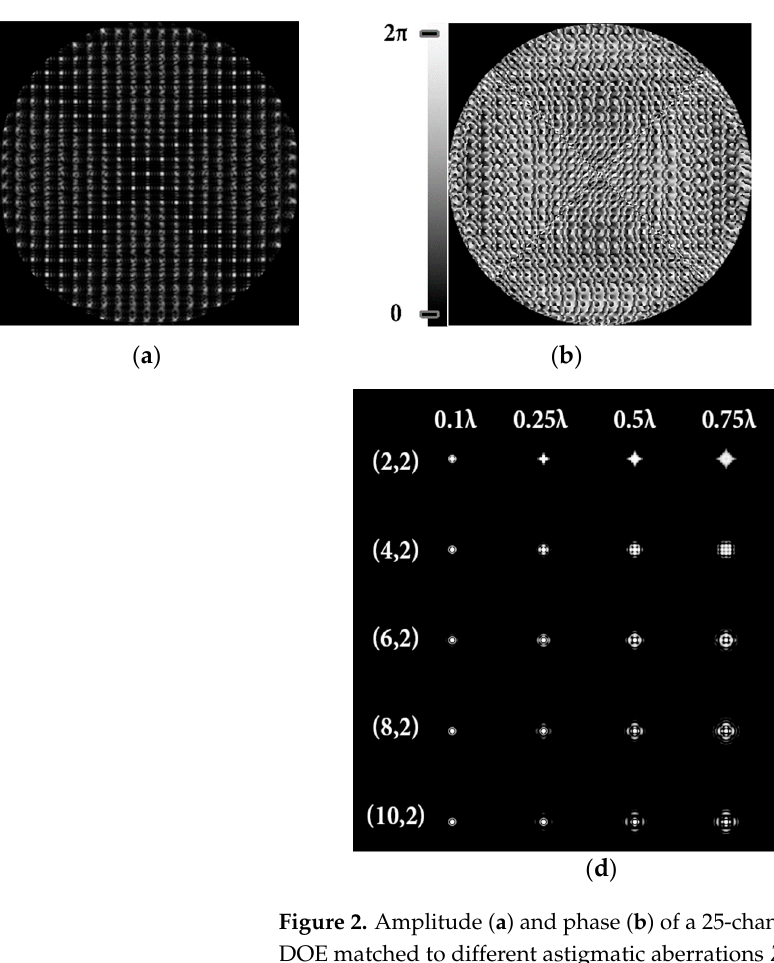
α , intensity distribution in the focal plane ( d ) at the Gaussian beam illumination (correspondence of j